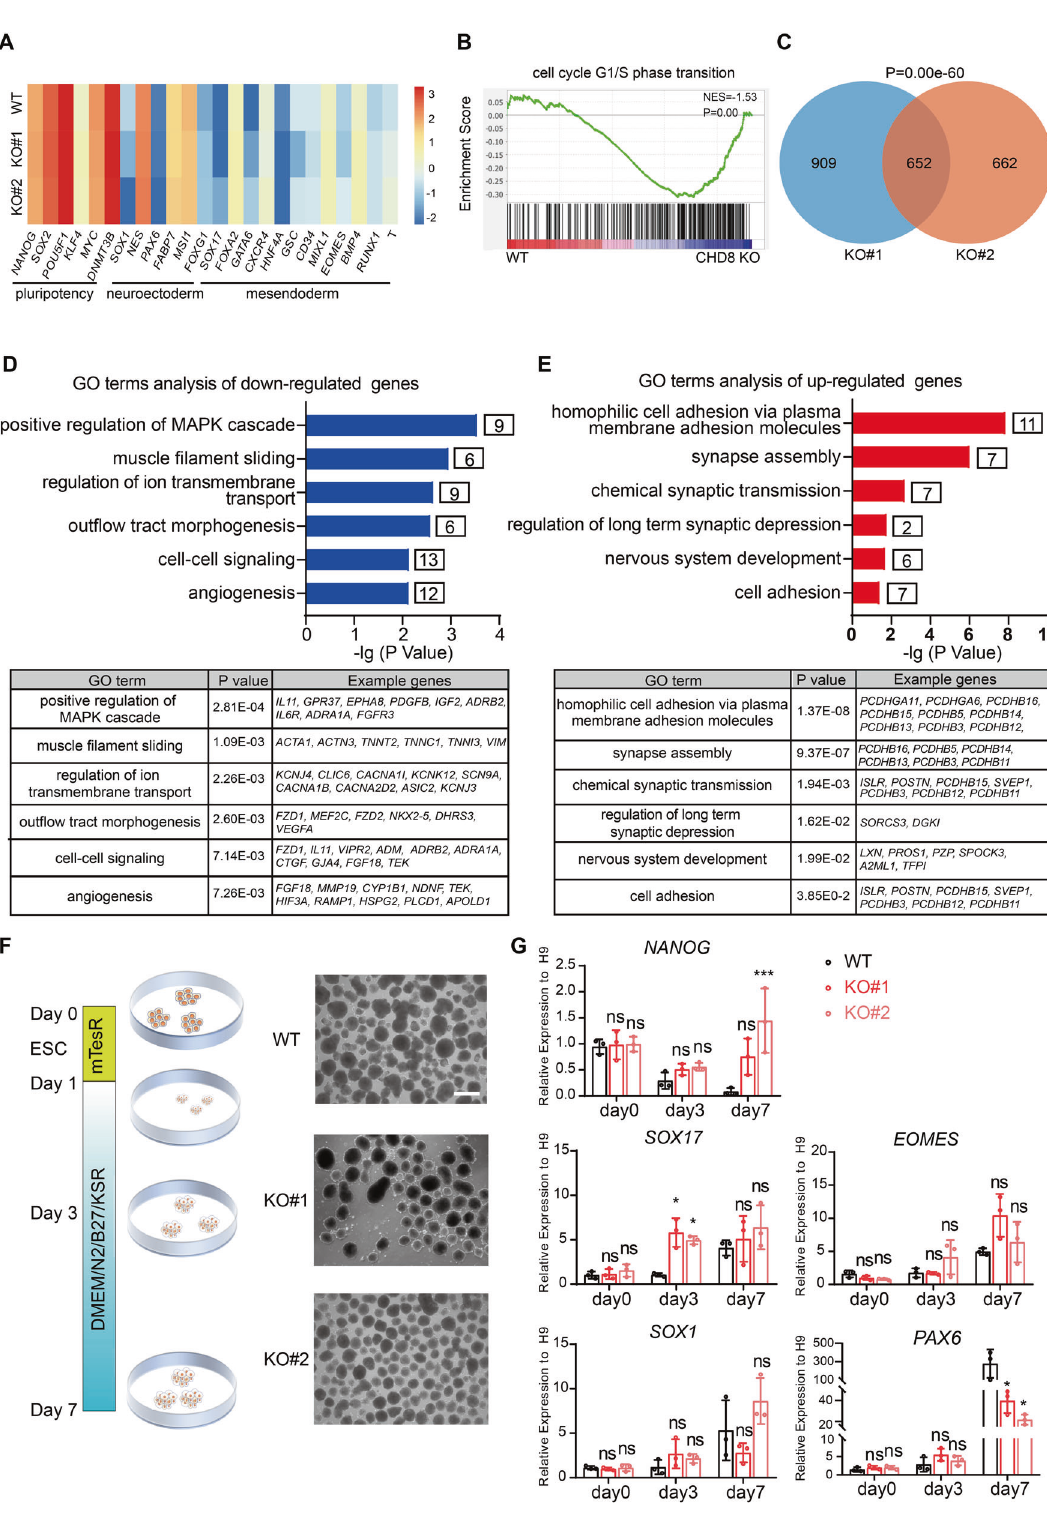
Fig. 3 Transcriptome analysis and EB assay for CHD8-KO ESCs. A Heatmap showing representative genes of pluripotency and lineage speci fi cation in the RNA-seq analysis of CHD8-KO#1, KO#2 and WT ESCs. B The GSEA showing the cell cycle related genes in WT and CHD8-KO ESCs. C Venn diagram showing the number and P- value of overlap DEGs between KO#1 and KO#2 compared with WT. D , E GO terms of down- and up-regulated genes in CHD8-KO ESCs. F Schematic diagram showing the EB formation assay and bright- fi eld images of WT and CHD8-KO EBs at day 7 ( n = 3). G RT-qPCR of selected genes during EB formation ( n = 3). The error bars represented the mean ± SD and the signi fi cance level was calculated by Student ’ s t -test (two-tailed, equal variance) (ns means not statistically signi fi cant, * P < 0.05, ** P < 0.01, *** P <